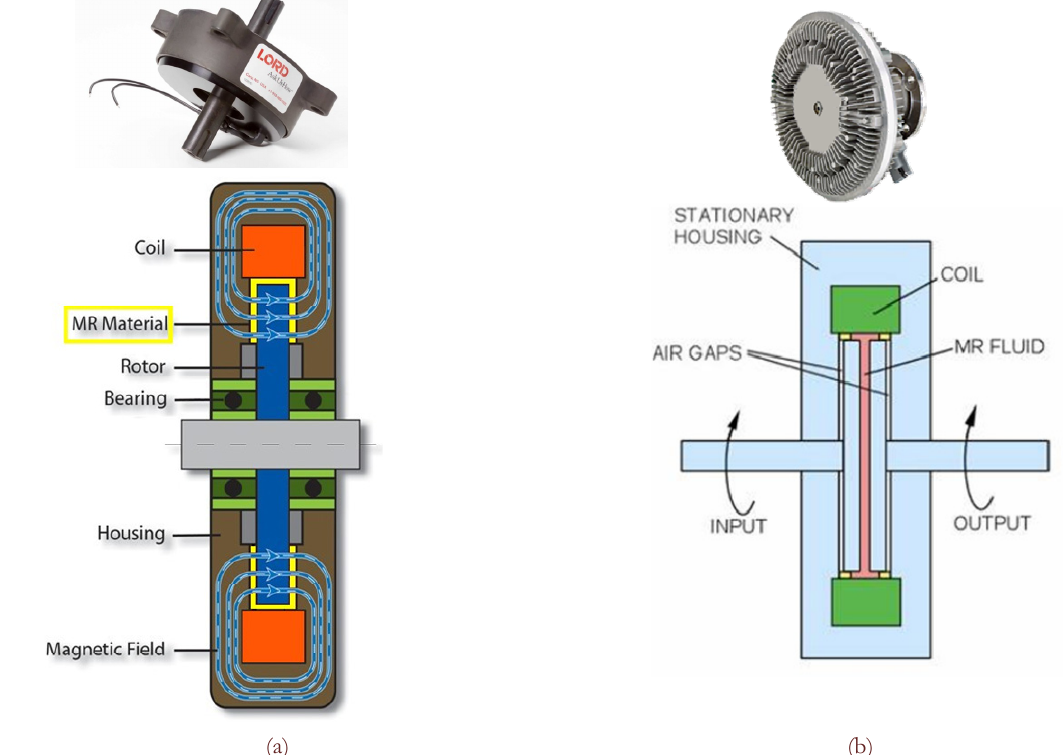
Figure 6: Picture and schematic of MR based brake (a) and clutch, both produced by Lord [1]. Rotary MR